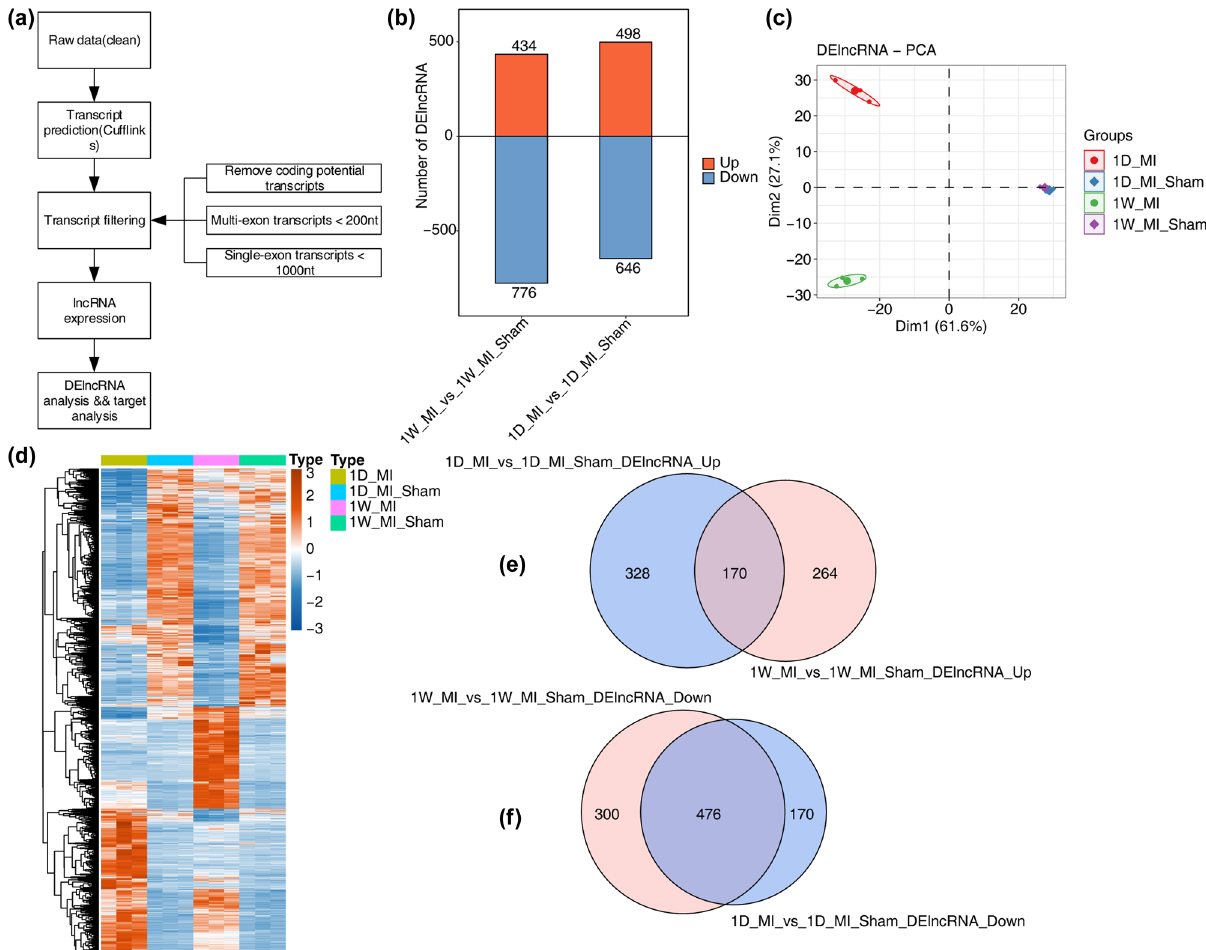
Figure 1: Genome - wide pro fi ling of MI - associated lncRNAs. ( a ) Illustration of the experimental design and bioinformatics analysis pipeline for the identi fi cation and functional annotation of lncRNAs expressed in MI and sham samples. ( b ) The number of di ff erentially expressed lncRNAs ( DE lncRNAs ) among the 1 - day ( 1 D ) and 1 - week ( 1 W ) groups. The number of upregulated and downregulated DE lncRNAs is shown in the bar plot. ( c ) PCA of MI and sham samples based on the normalized expression level. The samples were grouped by disease state, and the ellipse for each group is the con fi dence ellipse. ( d ) Expression heatmap of DE lncRNAs among MI and sham samples. ( e and f ) Venn diagram of DE lncRNAs in MI and sham samples at 1 day ( 1 D ) and 1 week ( 1 W )